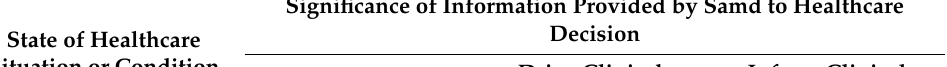
Table 2. International Regulators Forum SaMD Risk Framework (retrieved from International Medical Device Regulator Forum, IMDRF). The left column represents the state of the condition relative to the significance of the information from the SaMD driving medical care. The roman numerals (I–IV) describe the risk (significance) associated with the clinical situation, with I being low and IV being